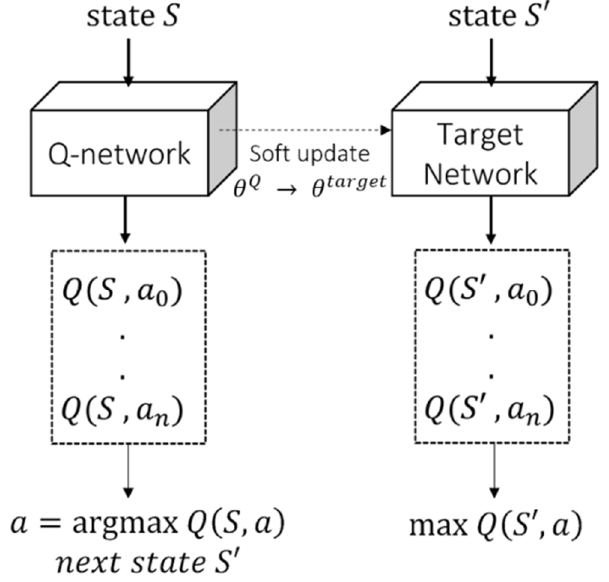
Figure 1. Training process of DDQN. DDQN has two neural networks to predict the Q-value for allowable actions at the input state. The action expected to take the maximum reward would be selected.